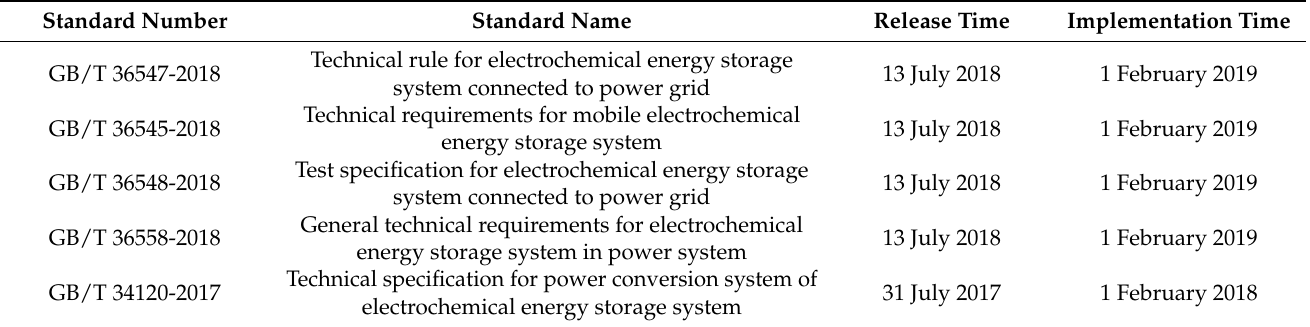
Table 1. Five national standards released during 2017 – 2018 in China.